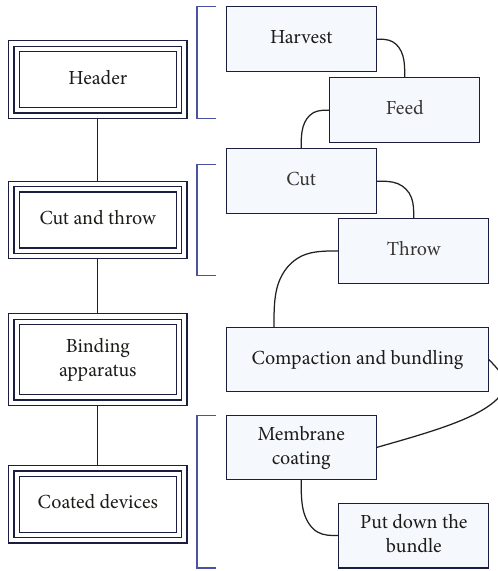
Figure 1: Flowchart of the whole machine operation.